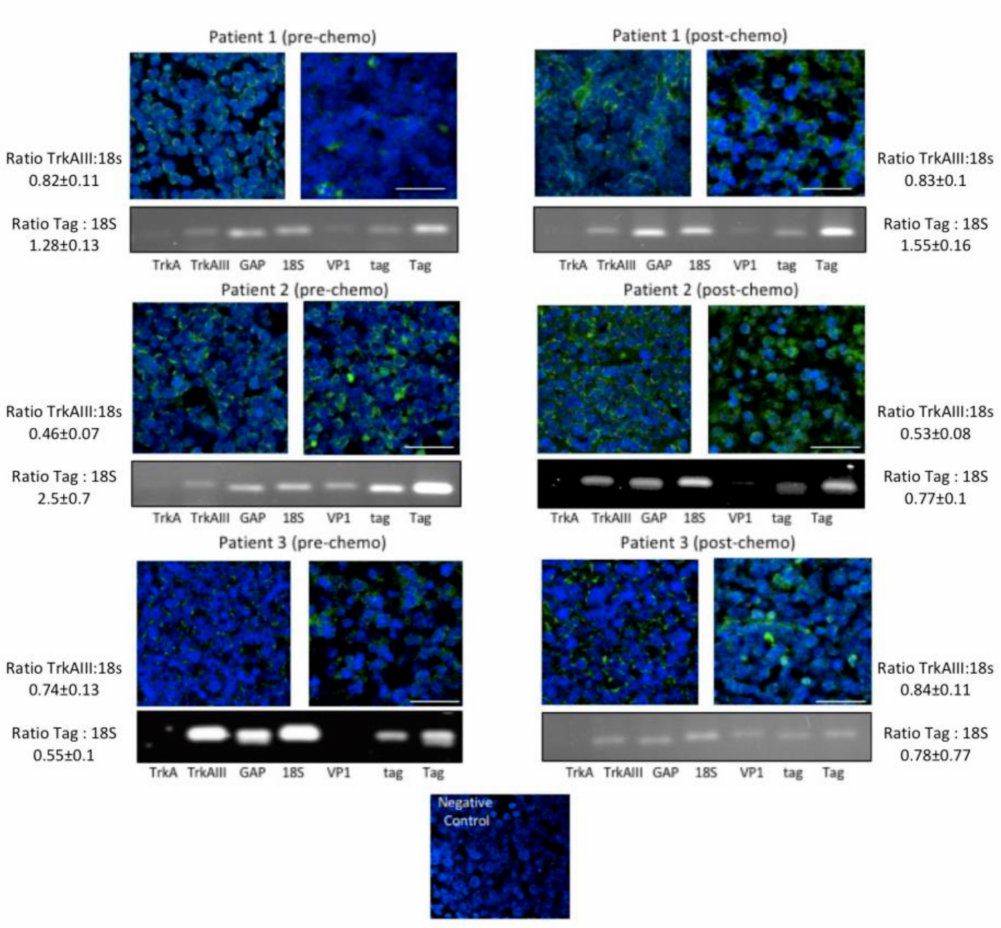
Figure 3. Representative indirect immunofluorescence (IF) micrographs demonstrating immunoreactivity to anti-TrkA and anti-Y490 phosphorylated TrkA antibodies in 5 µ m formalin-fixed paraffin-embedded (FFPE)sectionsofprimaryMCCsfrom3patientspriortochemotherapy(prechemo)andpostchemotherapy (postchemo) recurrent MCCs from the same patients (bar = 50 µ m). Negative control represents MCC FFPE tissue from Patient 3 incubated with preimmune rabbit IgG and secondary FITC conjugated anti-rabbit antibody. Under each set is a representative agarose gel demonstrating RT-PCR levels of TrkA, TrkAIII, glyceraldehyde 3-phosphate dehydrogenase (GAP), 18S RNA, MCPyV viral capsid protein (VP1), MCPyV small t-antigen (tag) and MCPyV large t-antigen (Tag) in RNAs purified from 50 µ m serial sections of the same FFPE MCC tissues. The densitometric ratios ( ± SD) of TrkAIII to 18S rRNA (TrkAIII: 18S) and MCPyV Tag to 18S rRNA (Tag: 18S) RT-PCR products are provided for each patient.